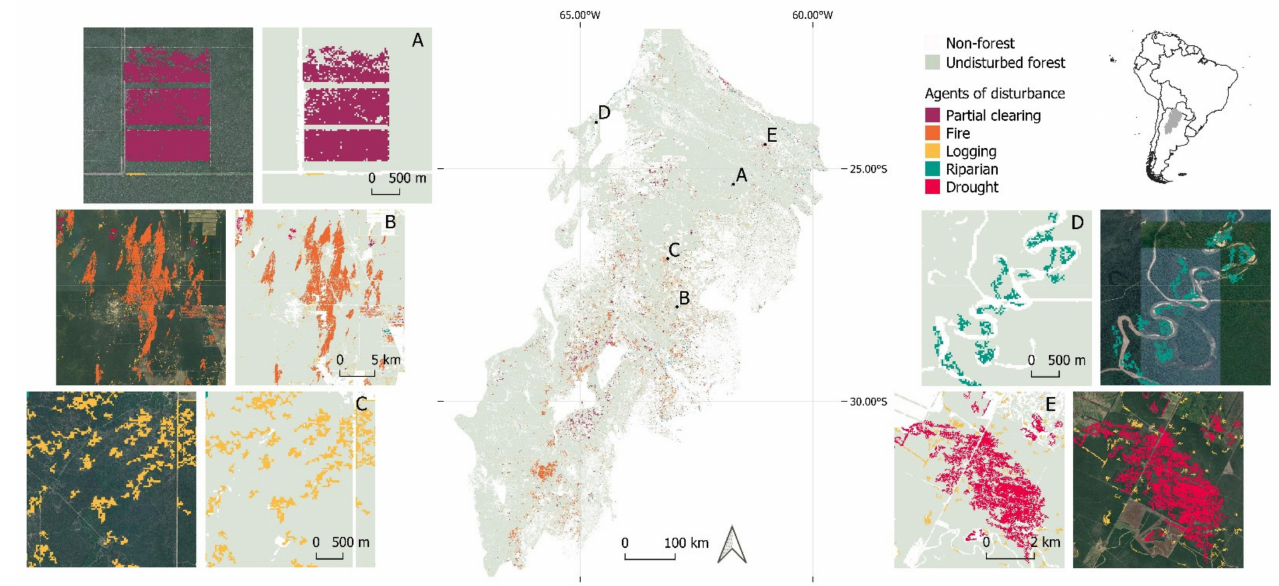
Figure 4. Map of forest disturbance agents for the Argentine Dry Chaco. Insets show examples for the five disturbance agents identified in our analyses: ( A ) Partial clearing, ( B ) Fire, ( C ) Logging, ( D ) Riparian change, ( E ) Dorught (Google Earth Imagery as